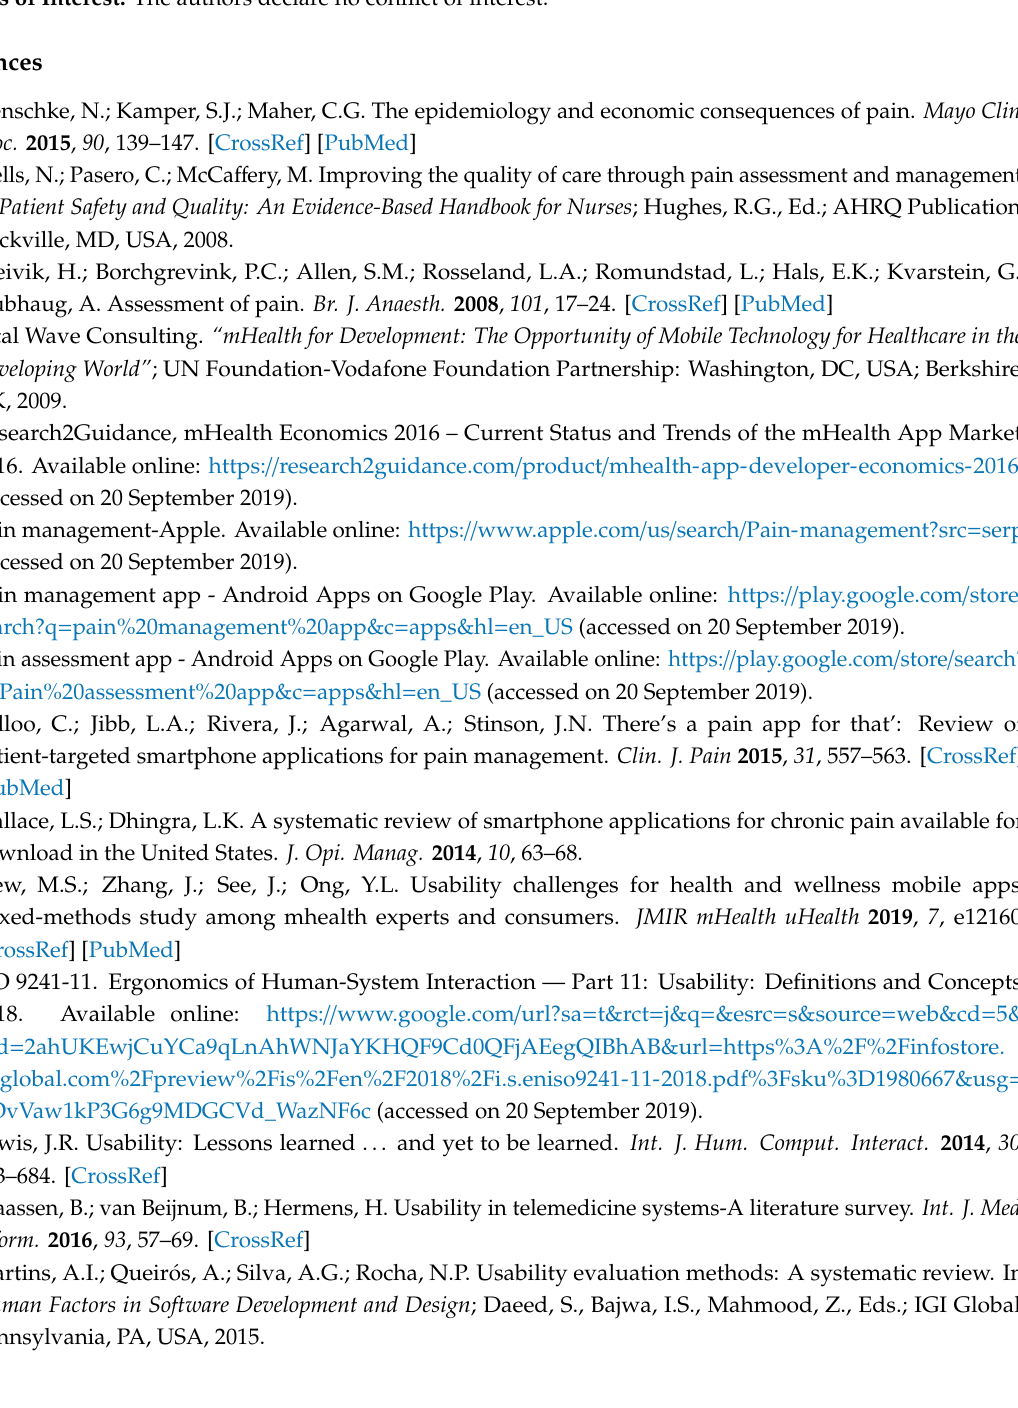
Table S1: Overview of the manuscripts included in the systematic